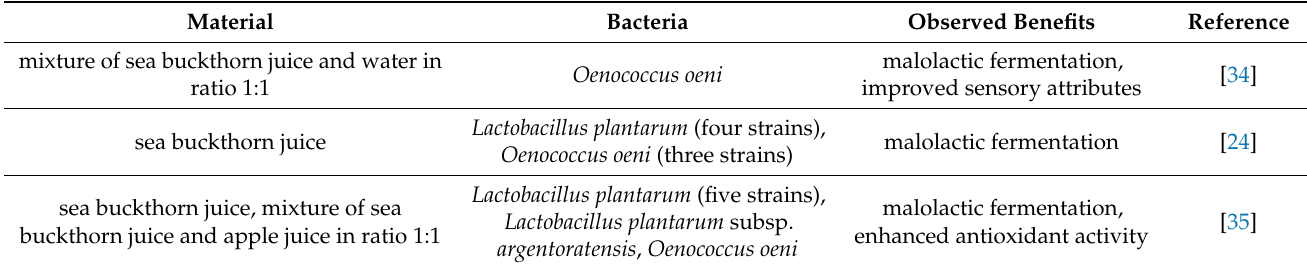
Table 1. Summary of studied fermented beverages containing sea buckthorn juice. Material Bacteria Observed Benefits